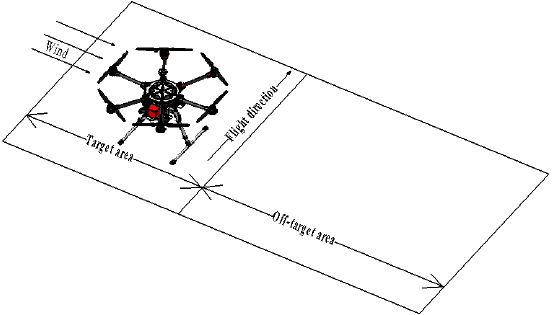
Figure 1. The sketch of UAV, wind and flight direction is shown in diagram to simulate the actual spray picture. The target area is set under the UAV and the off-target area is set down wind relative to the UAV.